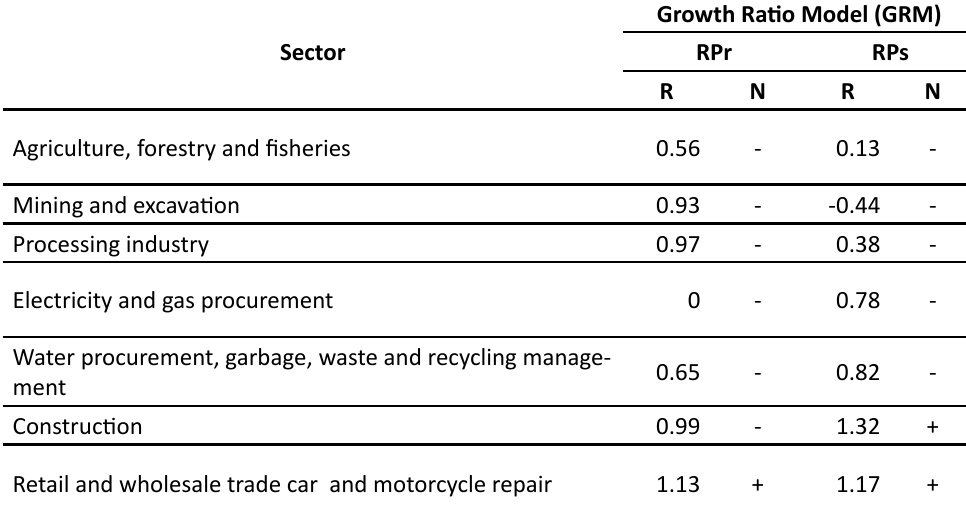
Table 3: Calculation results of Growth Ratio Model East Java Province and Malang